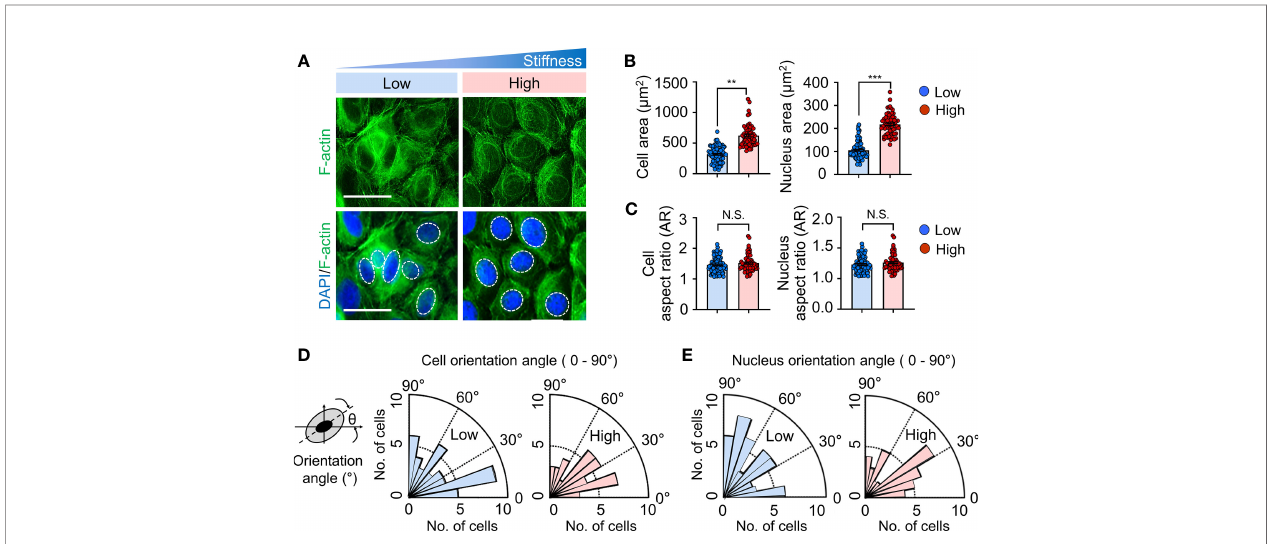
FIGURE 1 | Substrate stiffness alters morphology and cytoskeletal organization in keratinocytes. (A) Representative immuno fl uorescent images showing the nucleus (DAPI, blue) (indicated by the white dotted line) and F-actin (green) in HaCaT cells cultured on substrates with low (20 kPa) and high (1200 kPa) stiffness at day 1. Scale bar = 50 m m. The area (B) , aspect ratio [AR, (C) ], and orientation (D, E) of the cell and nucleus were quanti fi ed on HaCaT cells cultured on low- and high- stiffness substrates. All images were analyzed using the Cell Pro fi ler software. n = 350-1000 (B – E) . Data represent the mean ± S.E.M. ** p < 0.01; *** p < 0.001 by Student ’ s t -test. N.S., nonsigni fi